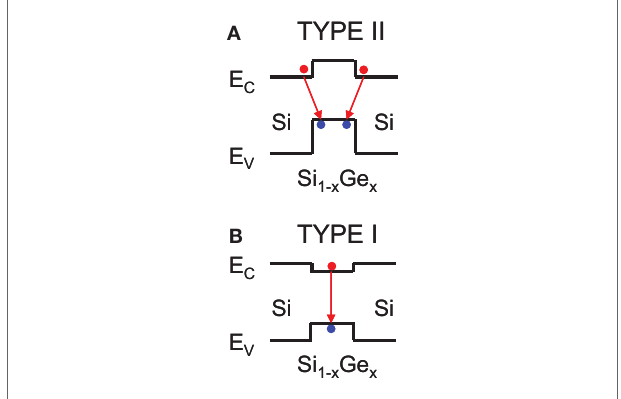
FiGURe 1 | Schematic representation of (A) type ii and (B) type i energy band alignments thought to exist in Si/Si 1- x Ge x nanostructures . E C and E V are the energies of the conduction and valence bands, respectively, in Si and Si 1 − x Ge x